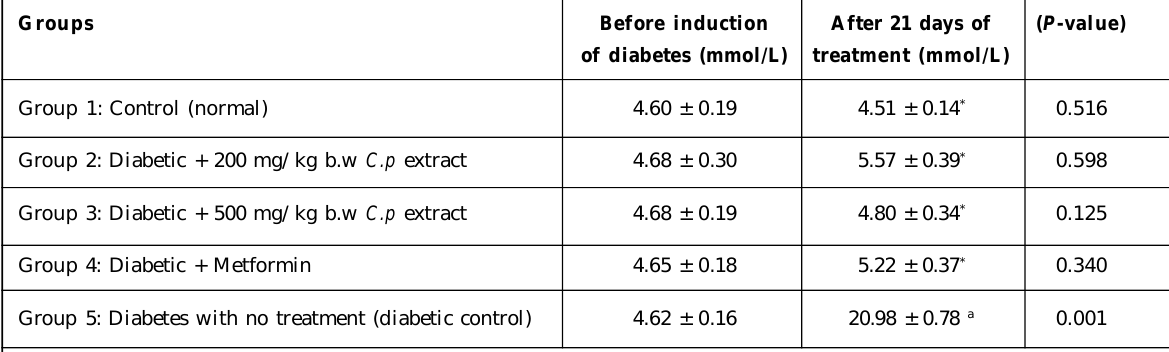
Table 2: The Mean ± SEM of the blood glucose of the Wistar rats, Normal control, those treated with C.p extract, metformin, and diabetic control (untreated) before and after induction of diabetes mellitus after 21 days Groups Before induction After 21 days of ( P -value) of diabetes (mmol/L) treatment (mmol/L)